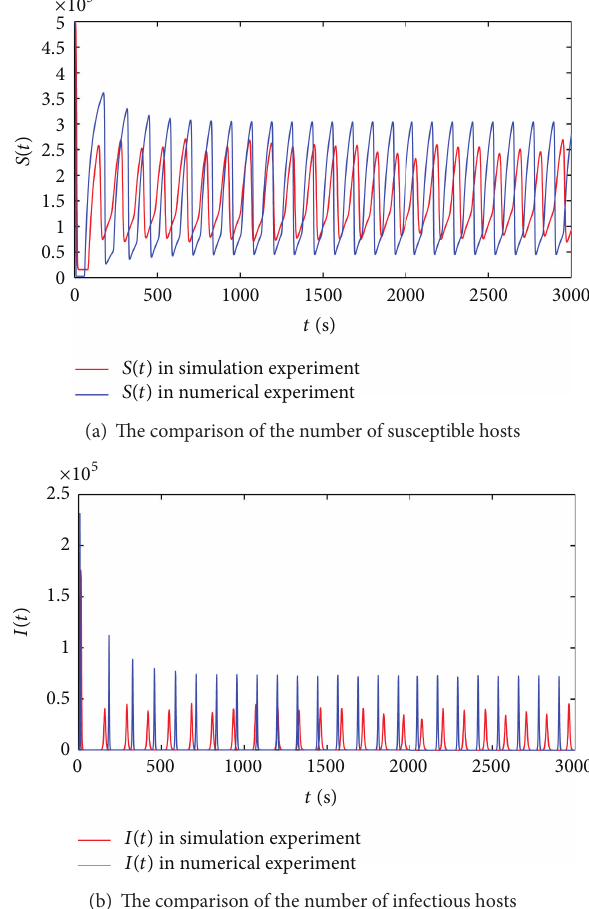
Figure 12: Simulation result of the three kinds of hosts when 𝜏 > 𝜏 0 .